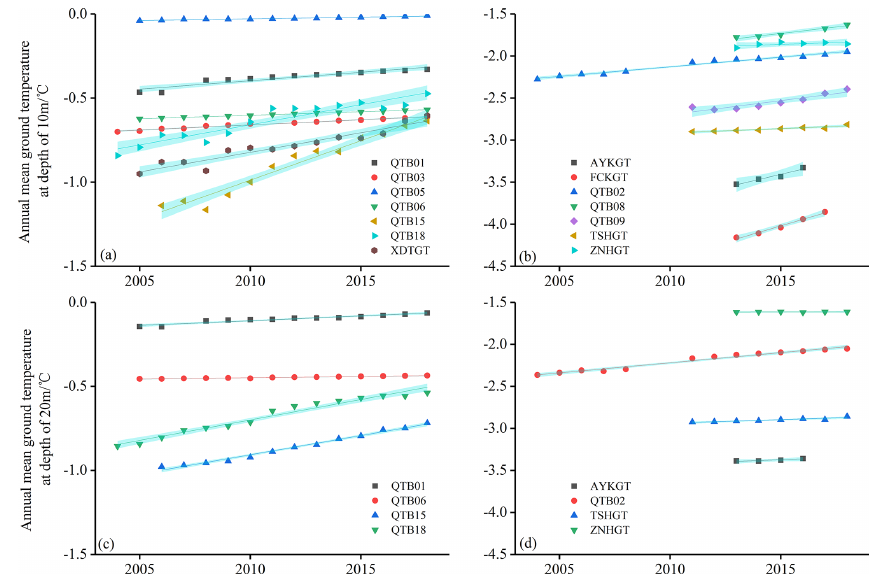
Figure 11. The relationship between warming rate and multiyear mean ground temperature during the observation period from the (a) active layer monitoring site and the (b) borehole